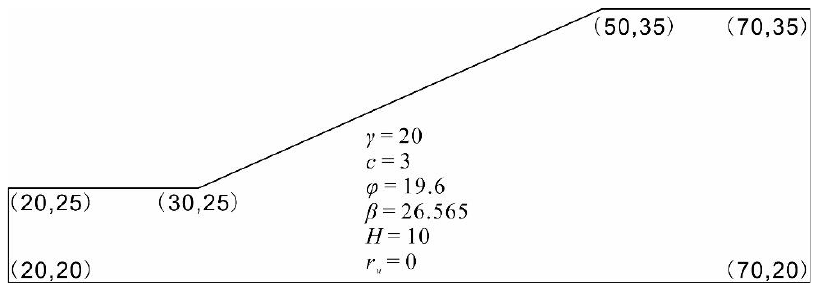
Figure 11. ACADS reference slope example EX1 (Unit: m).